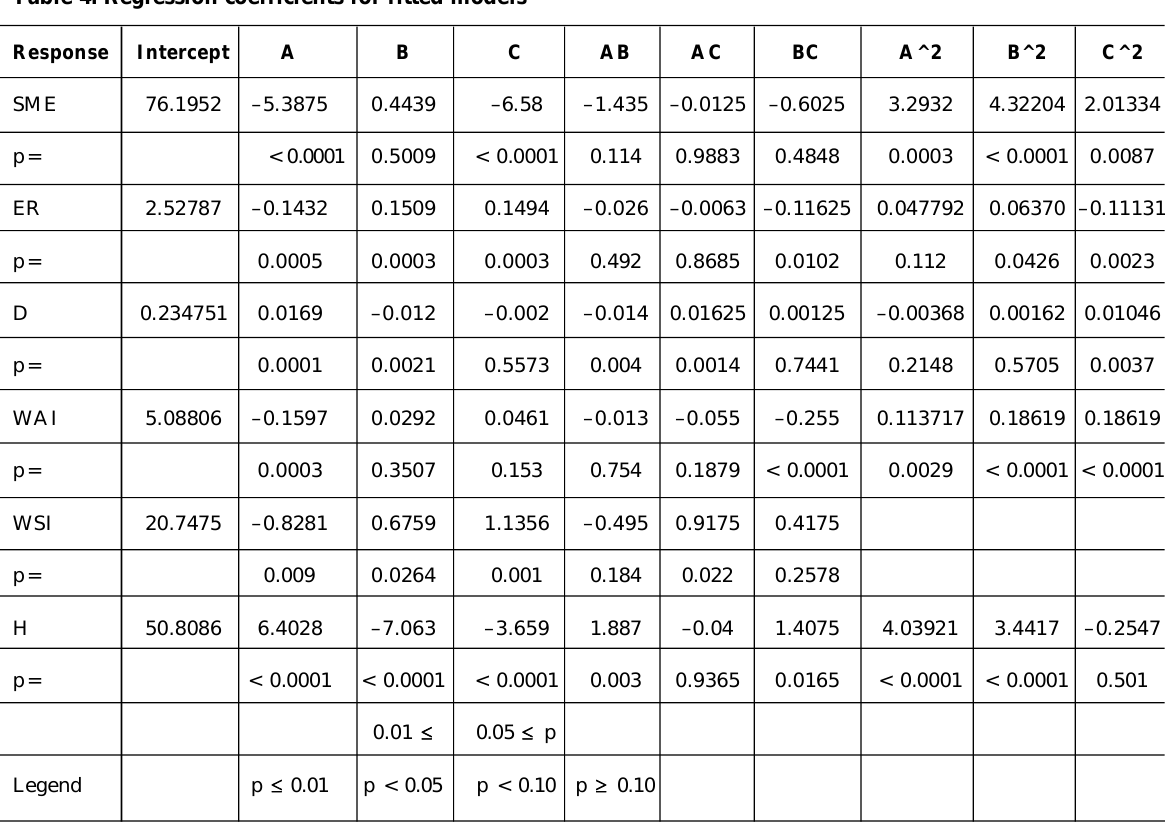
Table 4: Regression coefficients for fitted